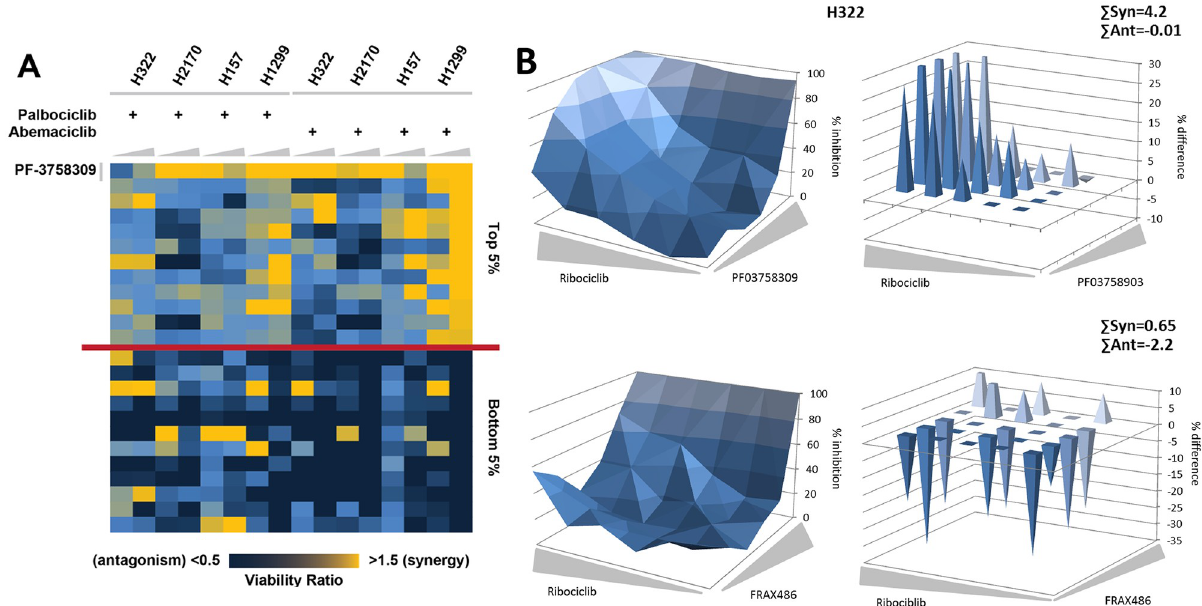
Fig 1. Combination drug effects of clinical CDK4/6is in lung cancer cells. A) Drug combination screening with a customized library of 240 targeted agents (0.5 μ M and 2.5 μ M, increasing wedge size) and either palbociclib (PD-0332991–2.5 μ M) or abemaciclib (LY2835219–0.75 μ M), depicted as a heat map, suggests synergy particularly with the PAK inhibitor PF03758309. B) Validation of drug synergy. Left panel: full dose-response matrix depicting inhibition of viability as determined using a CTG viability assay with varying drug concentrations (Ribociclib: 0–20 μ M; PF03758309 or FRAX486: 0–10 μ M). Right panel: deviation from calculated Bliss value for additivity (in % viability difference); needles pointing up indicate synergy, needles pointing down antagonism.